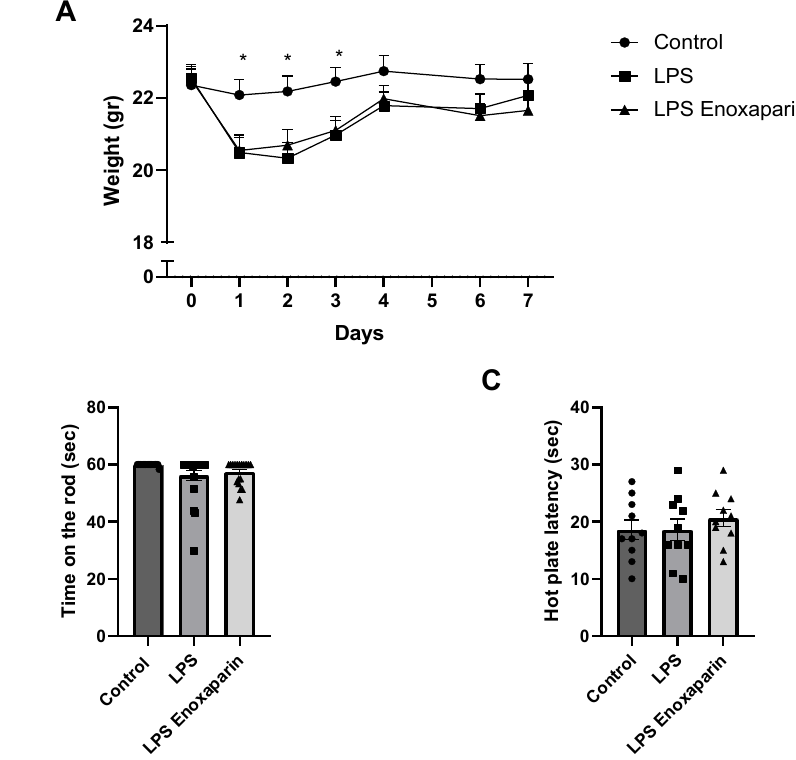
Figure 1. General health, motor deficits, and heat sensitivity: ( A ) LPS animals had significantly lower body weight until day 3, followed by improved body weight which normalized one week after injection (n = 20 for each group). ( B ) A trend toward motor deficits was observed between the LPS animals and the controls (control: n = 19, LPS: n = 20, LPS enoxaparin: n = 20). ( C ) No heat sensitivity changes were found between control, LPS, and enoxaparin-treated LPS (n = 10 for each group). * p < 0.05. LPS—lipopolysaccharide. Circles—control group; squares—LPS group; triangles—enoxaparin-treated LPS group.